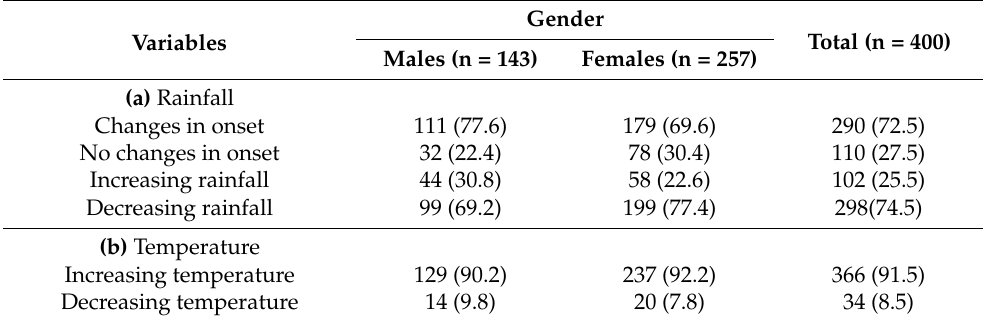
Table 5. Perception of respondents on rainfall and temperature changes.